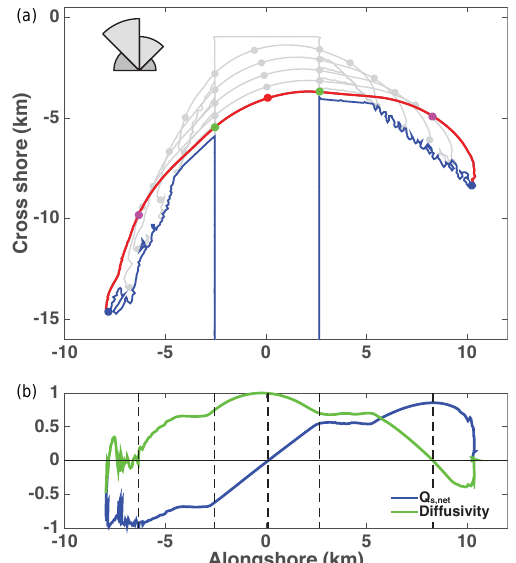
Figure 4. Model results showing (a) plan-view domain with spits growing off of an eroding headland experiencing asymmetrical wave conditions with (b) corresponding domain-normalized along- shore sediment transport and diffusivity. Results after 110 model years, with “ghost plots” every 22 model years. Red line indicates active spit shoreline and circles denote key morphologic locations: red circle is the nodal point, green circles are the locations of Q s,in , magenta circles are the fulcrum points, and blue circles are the spit ends where Q s = 0. Inset of flux-normalized wave climate in top panel ( A = 0 . 7 , U = 0 .